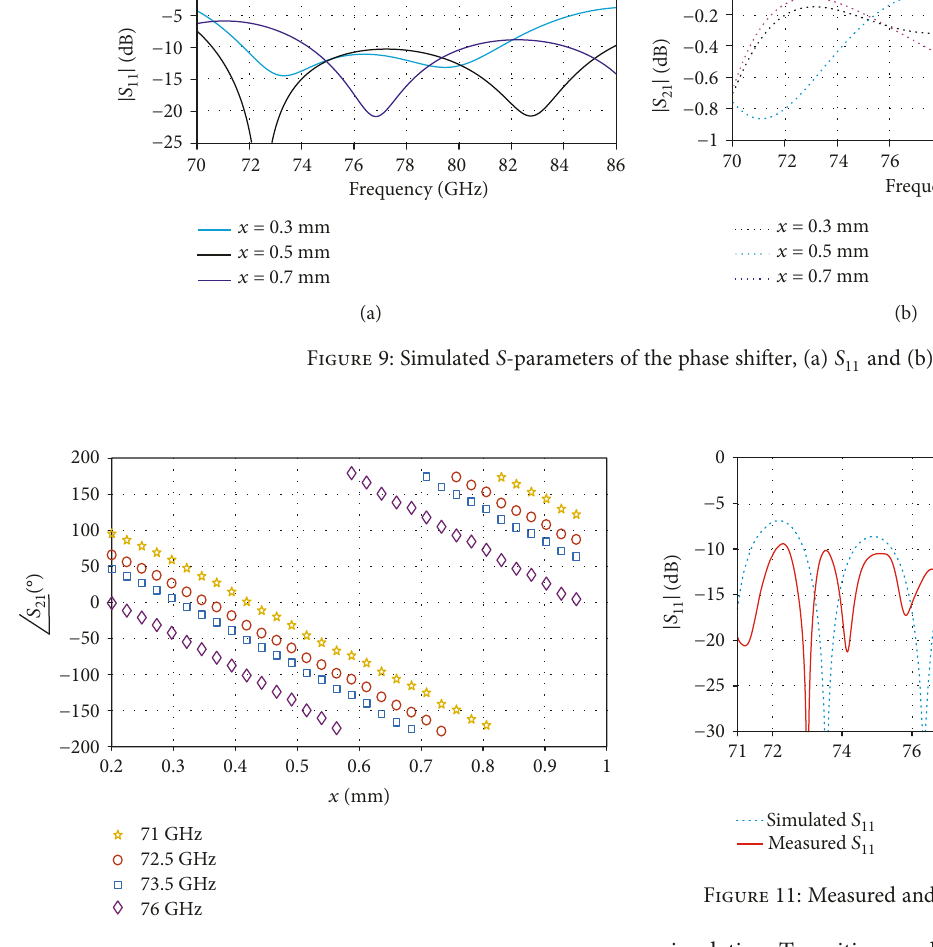
21 of the phase shifter as a